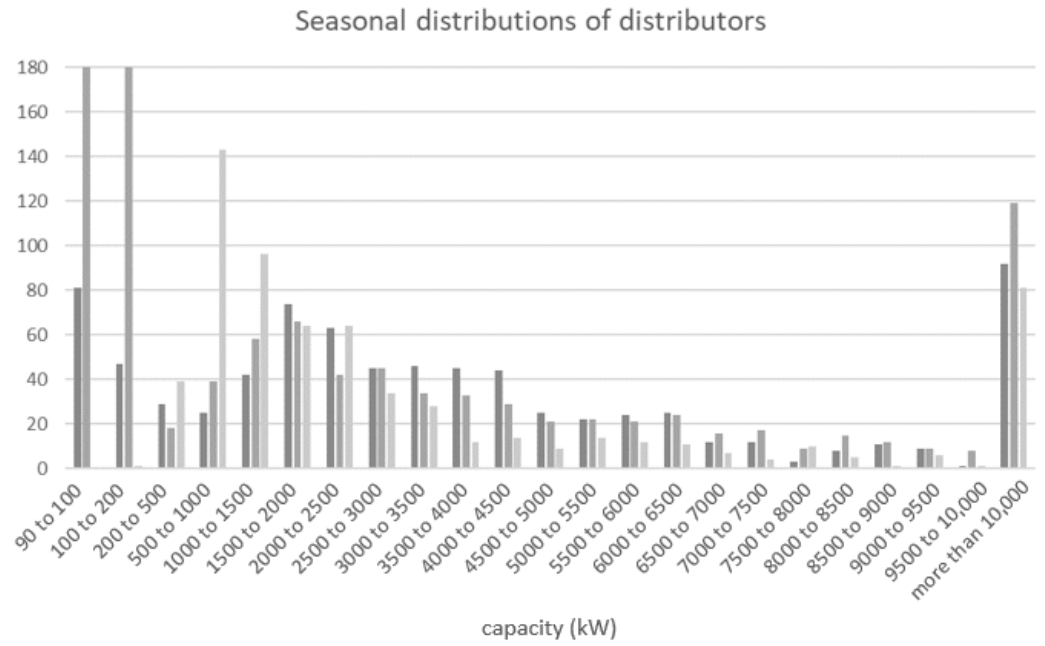
Figure 4. Distribution of distributors by sizes for 2035: critical scenario higher load and lower feed-in in the winter, transit, and summer periods.